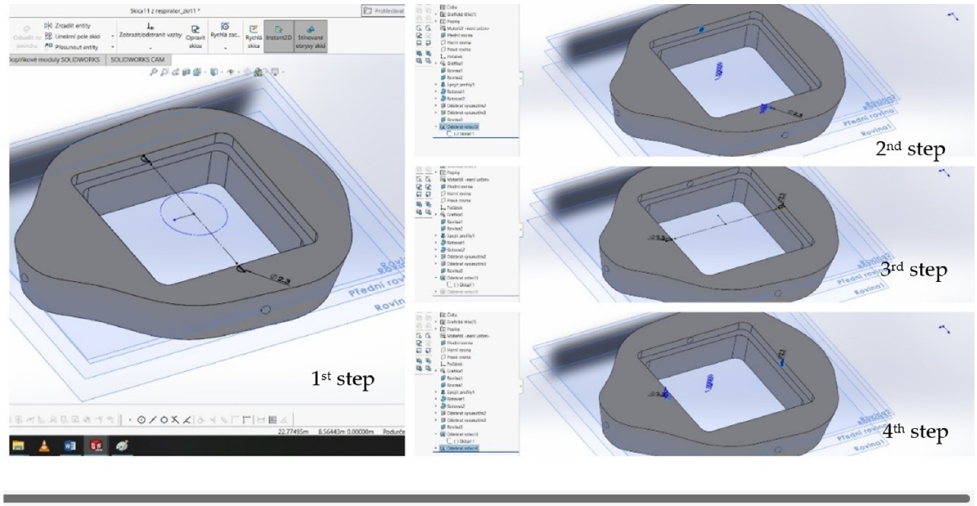
Figure 6. Creating semi-circular holes by selecting material (individual steps).